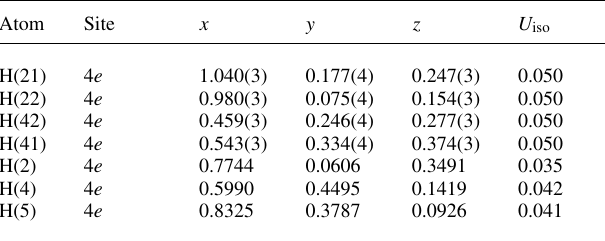
Table 2. Atomic coordinates and displacement parameters (in Å 2 )